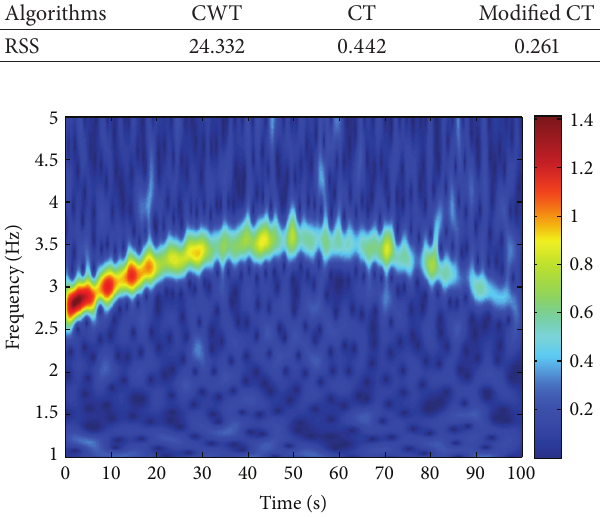
Figure 10: CWT scalogram of displacement response of case 2.